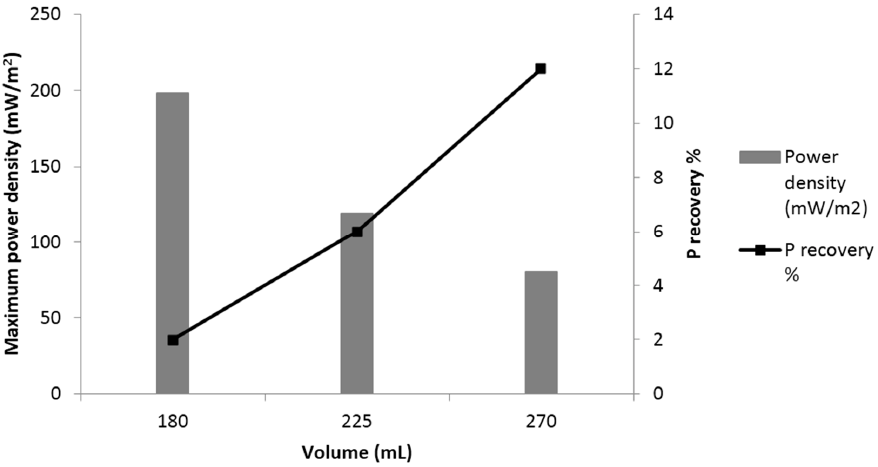
Figure 8. Maximum power density and P recovery % at different electrolyte volumes.